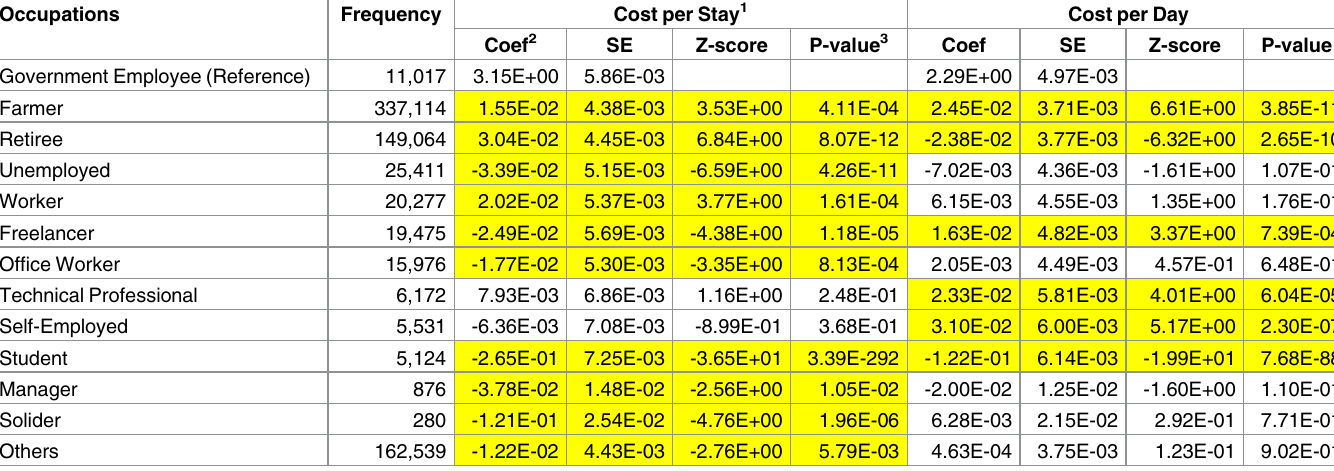
Table 4. Estimated cost per stay and cost per day across different occupations, where government employee is treated as the